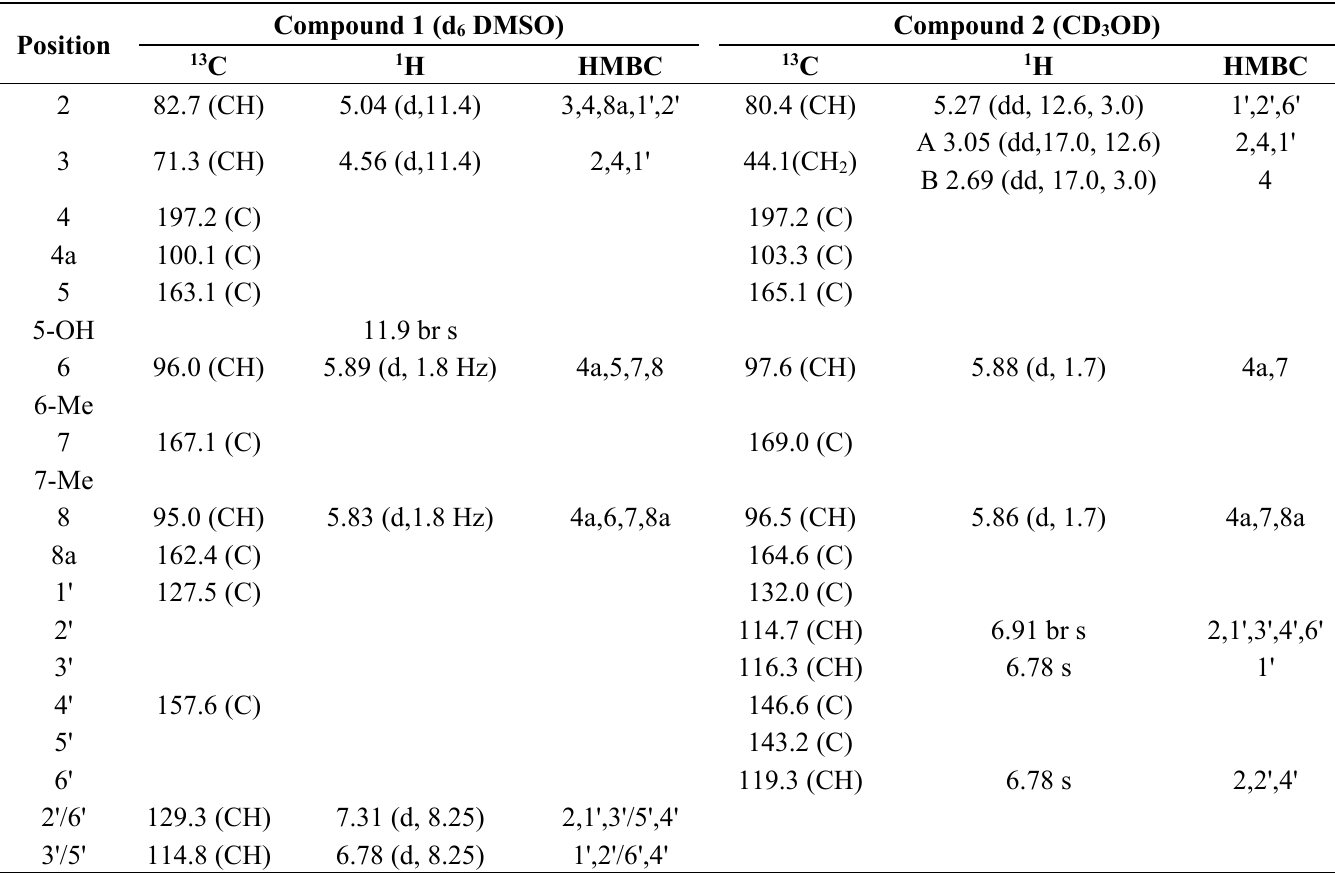
Table 1. 1 H and 13 C-NMR spectral data for compounds 1 and 2 from Corymbia